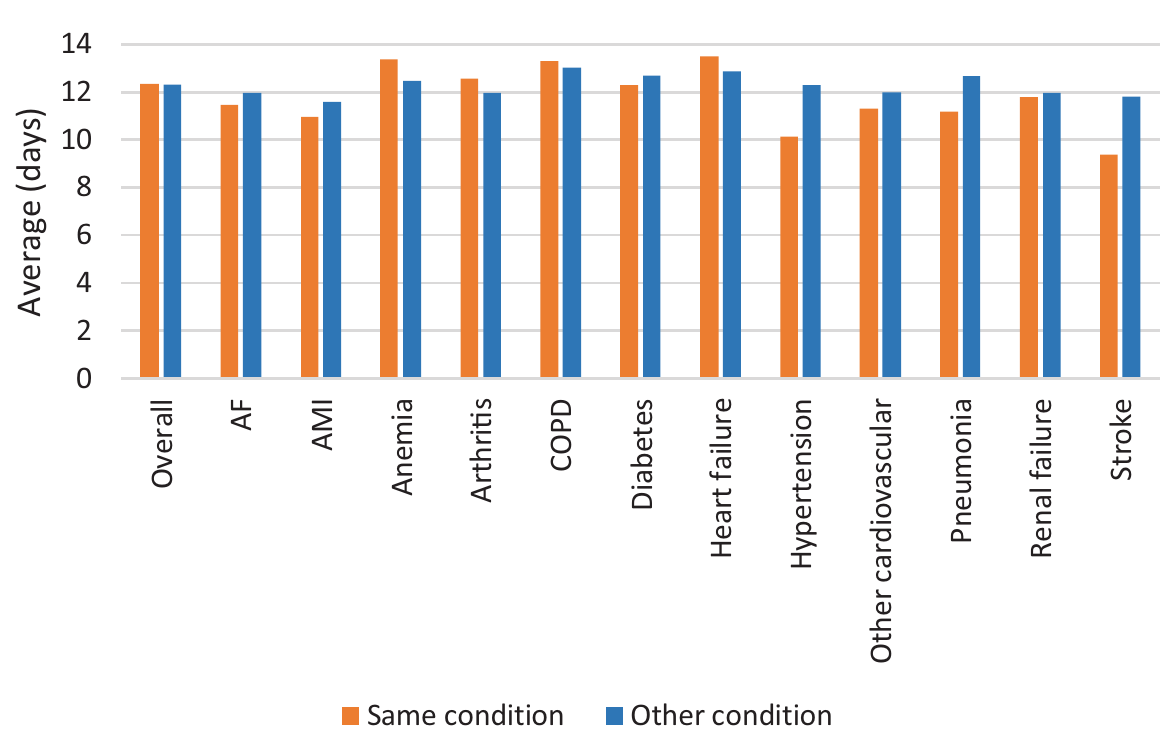
Fig 4. Average time to readmission overall and per original condition, depending on if readmission was due to the same or another condition. Abbreviations: AF atrial fibrillation; AMI acute myocardial infarction; COPD chronic obstructive pulmonary disease.